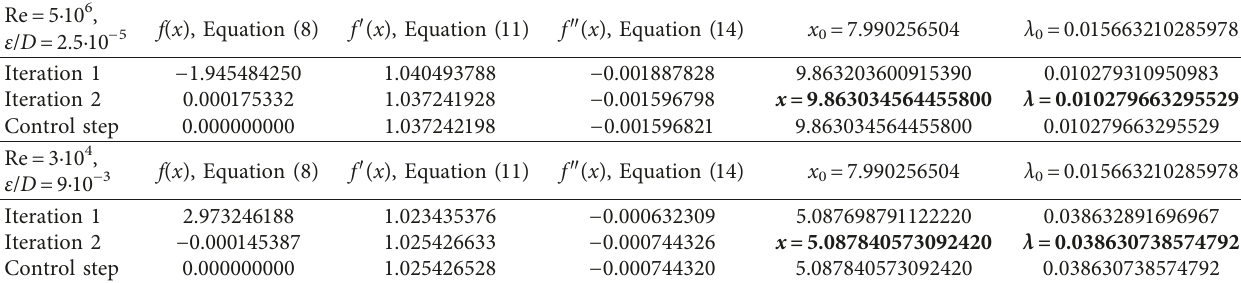
Table 5: Halley procedure. Option 5: fixed initial starting point x calculation of λ through the transmission factor x : Equation (13), and the symbolic derivatives f ′ ( x ) and f ″ ( x ): Equations (11) and (14).